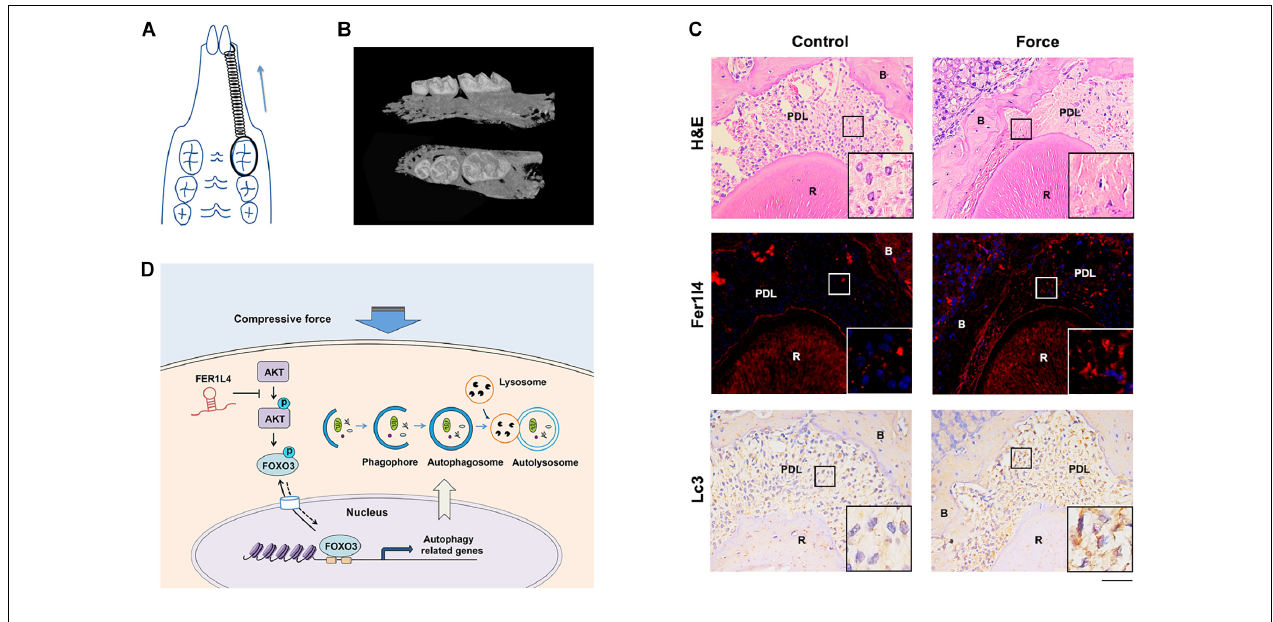
FIGURE 6 | Fer1l4 and Lc3 were upregulated in compressed periodontal ligament during orthodontic tooth movement. (A) Schematic diagram of mouse orthodontic tooth movement model. (B) Reconstructed three-dimensional micro-CT images of tooth movement. (C) H&E staining, FISH images of Fer1l4, and immunohistochemical staining of Lc3 in periodontal ligament of upper first molar with or without compressive strain. Scale bar: 100 µ m. ( n = 3). (D) Schematic diagram showing FER1L4 mediates the autophagy of periodontal ligament stem cells under orthodontic compressive force via AKT/FOXO3